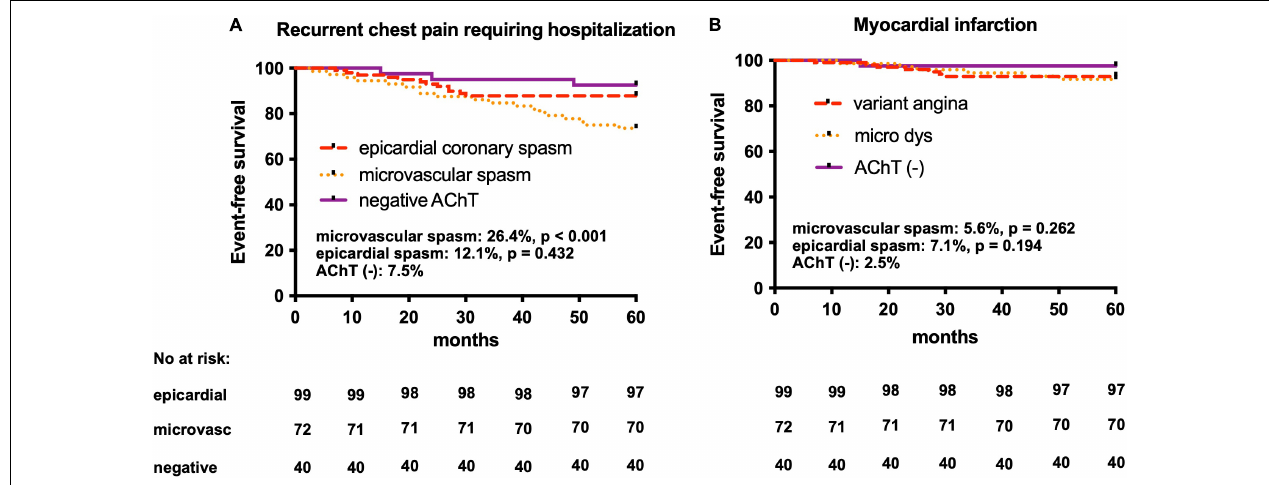
FIGURE 3 | Kaplan–Meier curves in the AChPOL population. (A) Event-free survival from recurrent chest pain events requiring hospitalization at 5-year follow-up in three groups: epicardial coronary spasm, microvascular spasm and negative AChT (B) Event-free survival form myocardial infarction at 5-year follow-up in three groups: epicardial coronary spasm, microvascular spasm and negative AChT. AChT, provocative test with acetylcholine. Log-rank test: epicardial spasm vs. AChT negative groups and microvascular spasm vs. AChT negative groups.